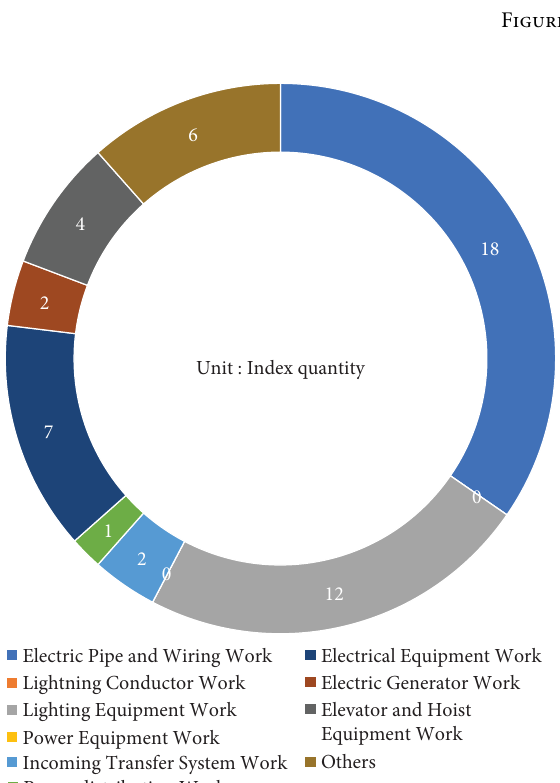
Figure 3: Case status.